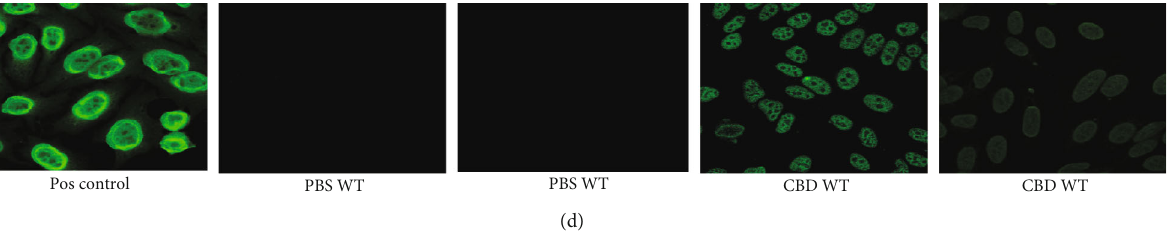
Figure 5: Characterization of B cell involvement in CBD mice. (a) Quanti fi cation of the numbers of focal dense in fi ltrates in lung sections, normalized for area in PBS-treated mice (white bar) and CBD mice (black bar) 8 weeks after initial exposure. (b) Flow cytometry analysis of B cells in single-cell lung digests of PBS mice (left) and CBD mice (right). CD19-positive cells are gated and analysed for IgM, IgD, PNA, and CD95. (c) Quanti fi cation of total B cells, CD95 + PNA + B cells, CD19 + CD138 + plasma blasts, and CD19-CD138 + plasma cells in single-cell lung digest of PBS controls (white bars) and CBD mice (black bars). (d) Serums obtained from the indicated mice were assayed on Hep2 slides to detect IgG autoantibodies; serums from MRL-lpr mice served as a positive control. The results shown were expressed as the means ± SEM ((a) and (c); Mann-Whitney U test: ∗ p < 0 : 05 ). The results shown represent one out of two independent experiments with 3-4 mice per